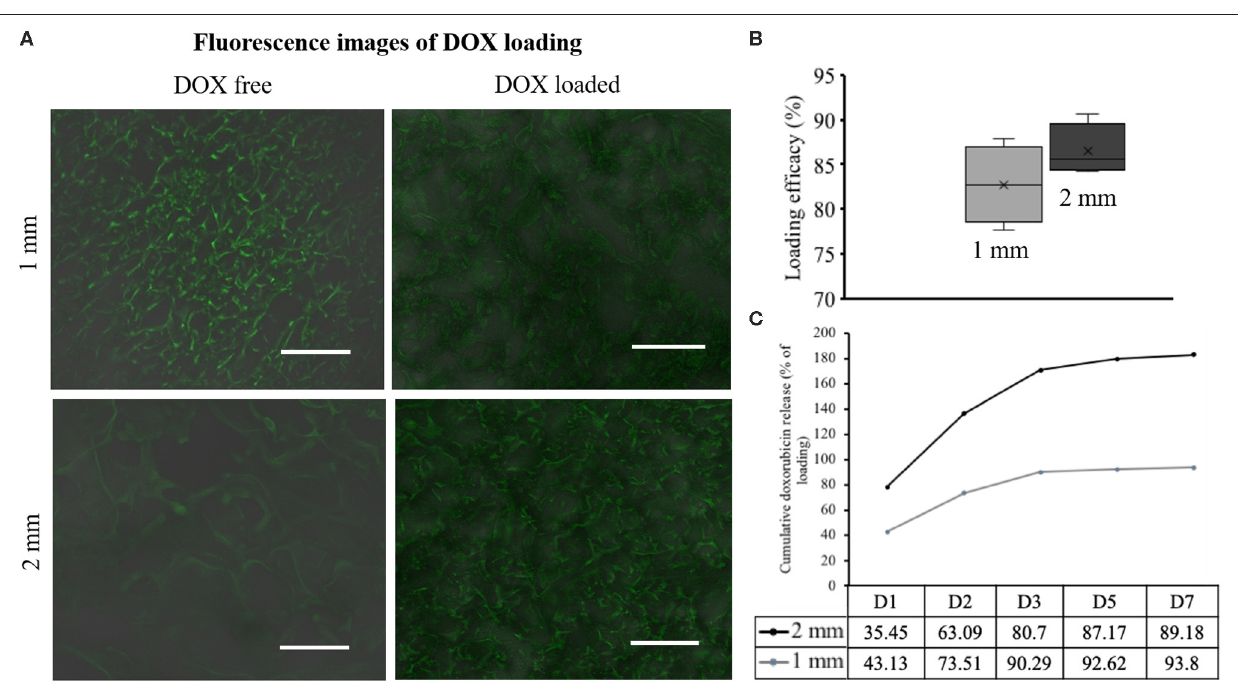
Frontiers in Materials |